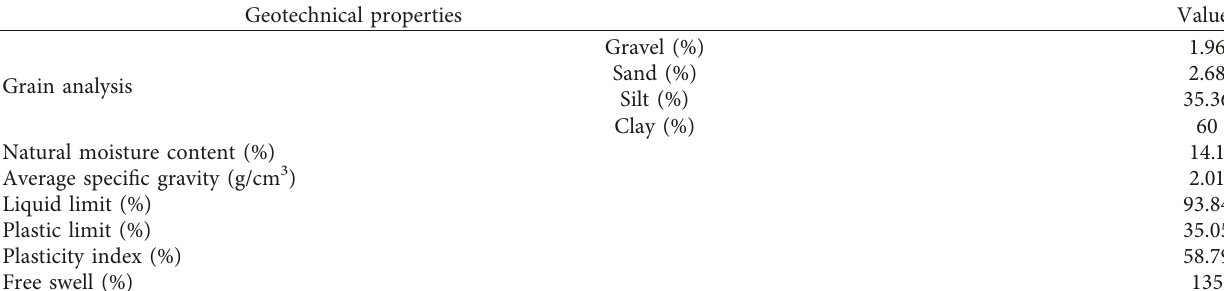
Table 1: Native soil geotechnical